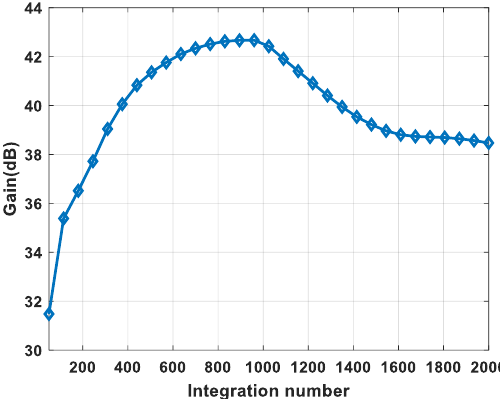
Figure 1. Coherent integration performance for partially coherent echo.